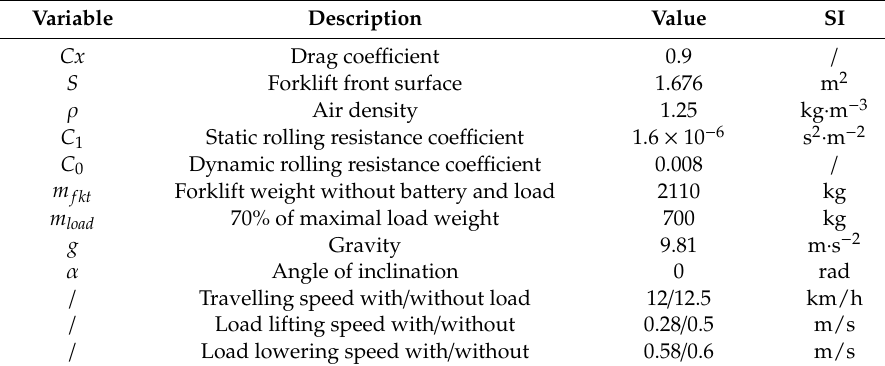
Table 1. Jungheinrich forklift dynamics.